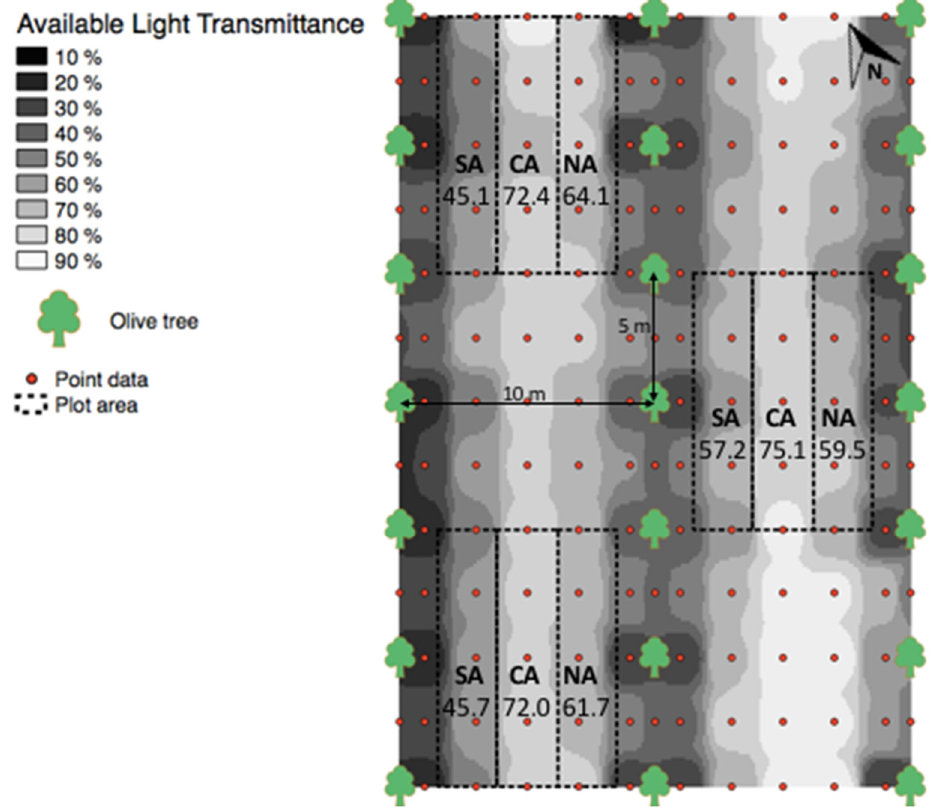
Figure 1. Spatial distribution of available light transmittance in the alley-cropping system (ACS) experiment site. Red dots represent point of hemispherical photo grid, while black dashed lines represent the sub-plots: (NA) north-facing side of the alley, (SA) south-facing side of the alley and (CA) central part of the alley. Labels inside alley plots indicate the average value of available light transmittance of each plot.